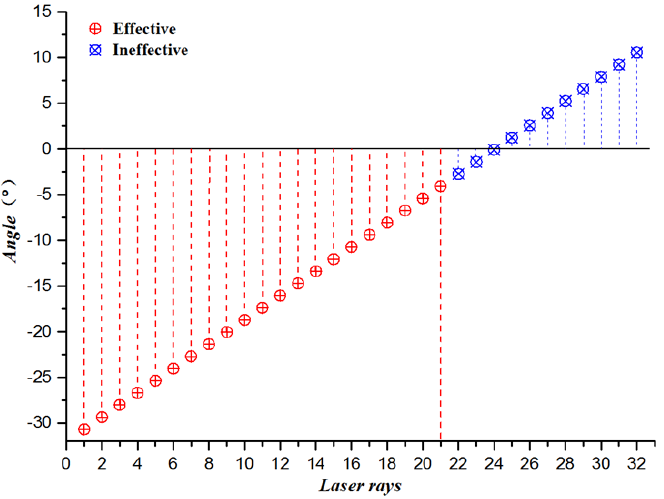
Figure 8. Schematic of the 3D Lidar scanning range selection.